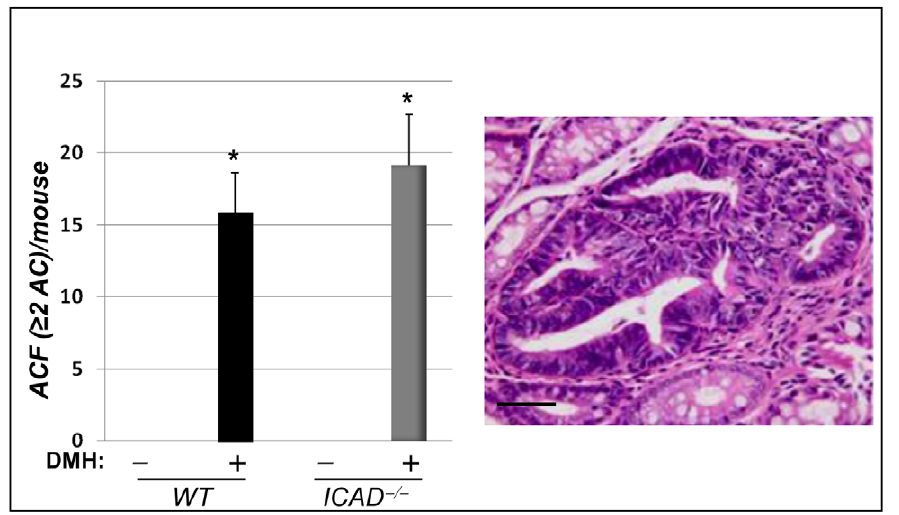
Figure 4. Effect of ICAD deficiency on ACF formation in DMH-treated mice. WT and ICAD 2 / 2 mice received DMH injections once a week for 8 weeks. Mice were sacrificed 12 weeks later. ACF were identified and counted in H&E-stained serial sections. Only ACF with 2 or more glands were included in the assessment; n=12. * Difference from DMH-treated WT mice, p , 0.05. The right panel represents an example of a large ACF in colon of a DMH-treated ICAD 2 / 2 mouse.